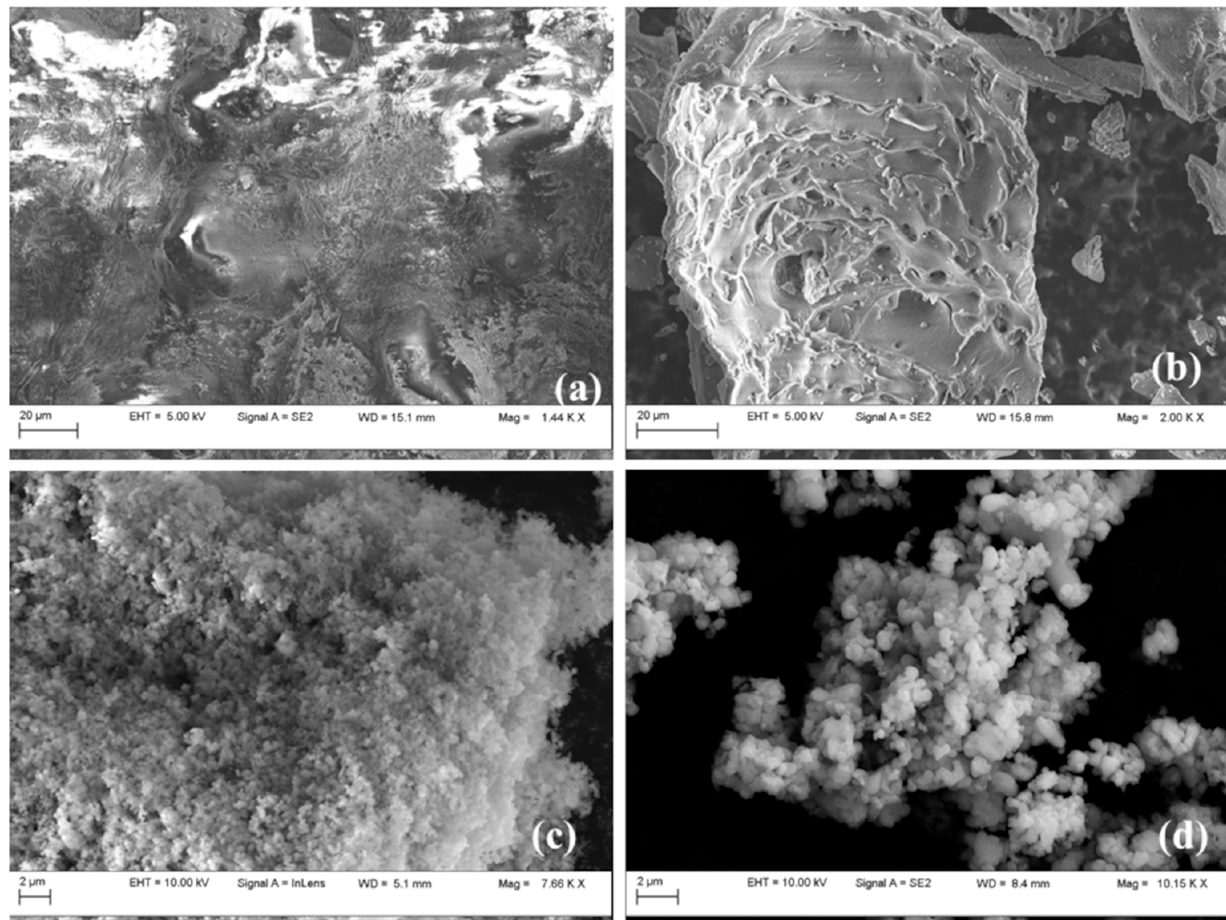
Figure 5. SEM images for RH ( a ), RHA ( b ), MCM-41 r ( c ), and MCM-41 c ( d ). After the metal introduction, SEM images confirmed that the ordered morphology was maintained (Figure 6).